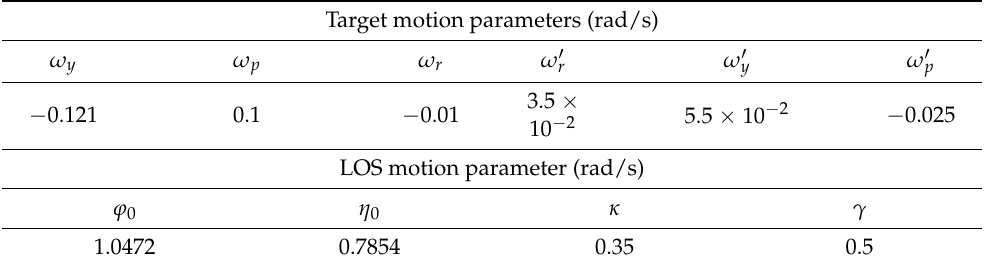
Table 1. Motion parameters of the targets and radar LOS parameters.